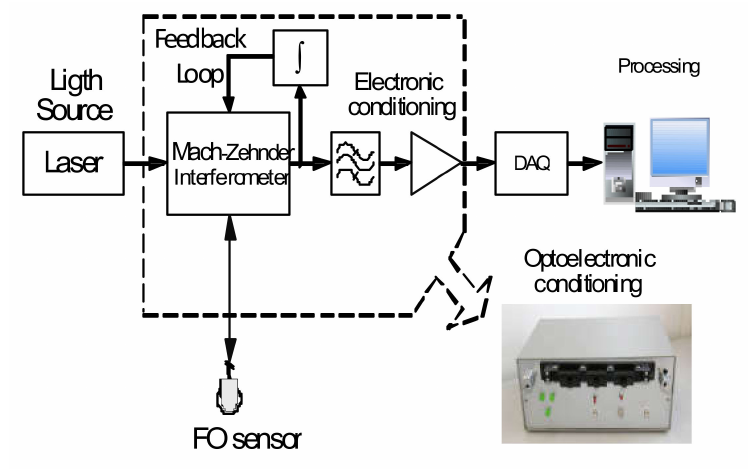
Figure 3. Single OF sensor.